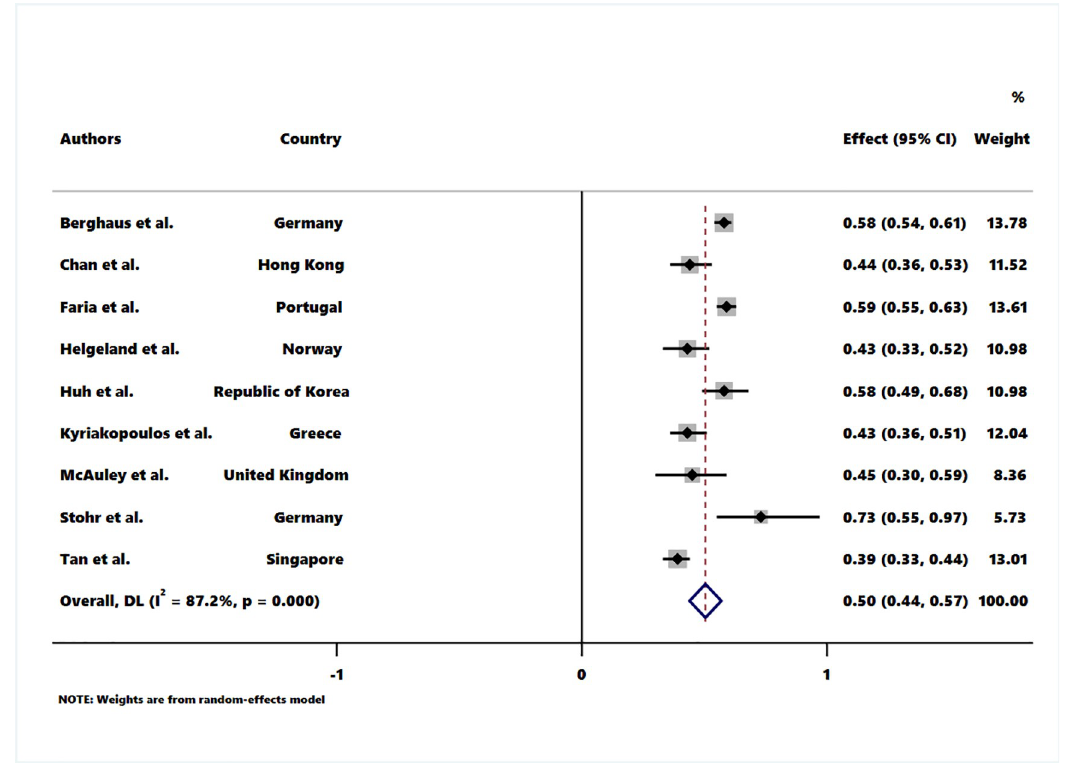
Fig 3. Pooled rate ratio of hospitalised COPD exacerbations in the post- compared to the pre-COVID-19 pandemic period.